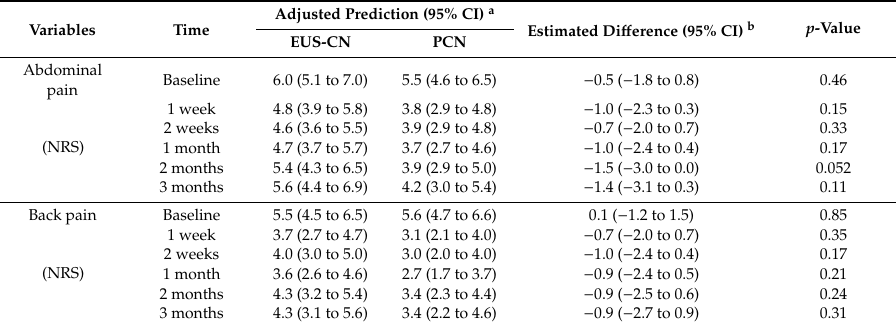
Table 2. Pain scores after EUS-CN or